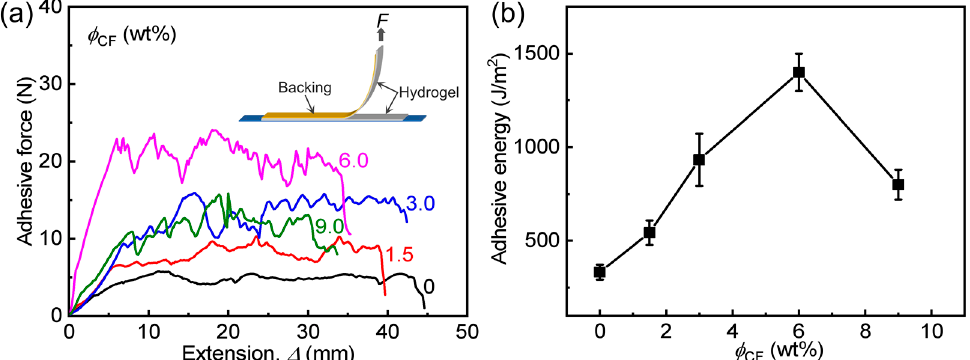
Figure 5. Lap-shear adhesion behavior of two pieces of PA/CF composite hydrogels with different ϕ CF . ( a ) Adhesive shear force ( F )-extension ( Δ ) curves of the samples. ( b ) Adhesive strength versus ϕ CF . Table 2. A summary of the adhesion properties of PA/CF composite hydrogels with different CF contents (shown in Figures 5–7).